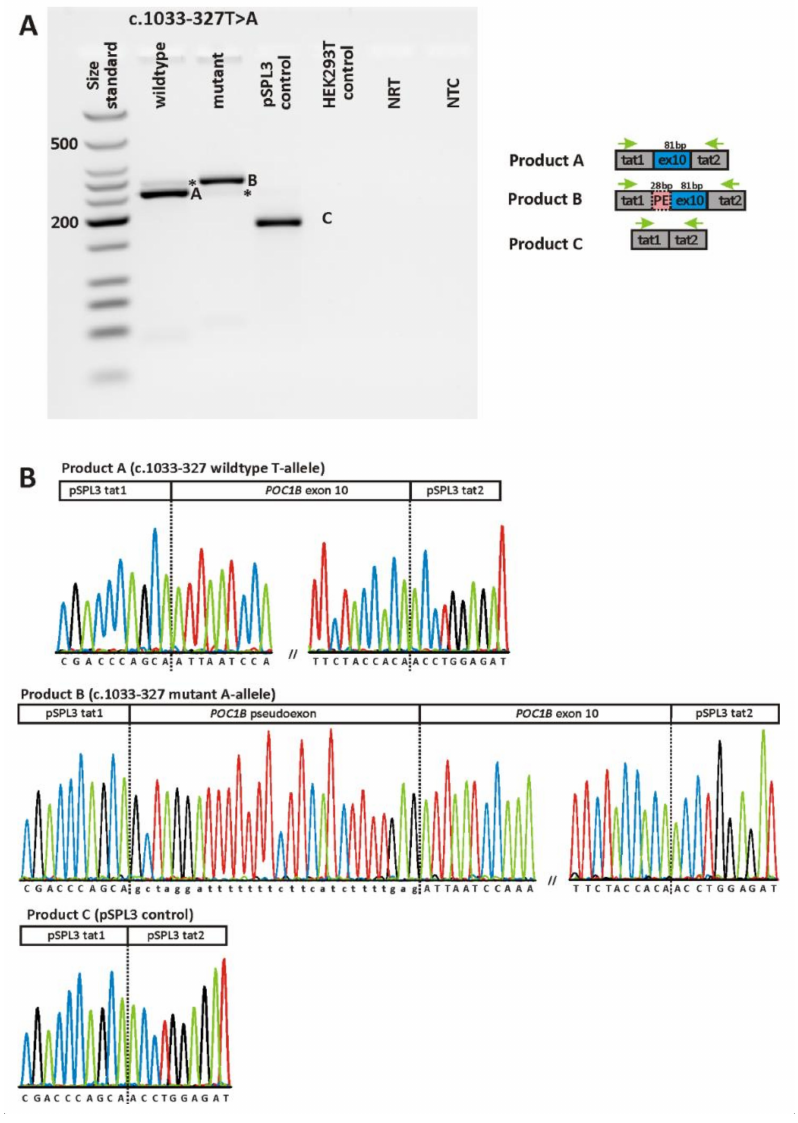
Figure 5. In vitro splicing assay for variant c.1033-327T>A. ( A ) Agarose gel electrophoresis of RT-PCR products. Gel loading is as follows: A size standard (low molecular weight DNA ladder, NEB) is loaded in the leftmost lane. RT-PCR products derived from HEK293T cells transfected with the plasmid construct harboring the wildtype allele are shown in lane 2, while those obtained upon transfection with the mutant allele are shown in lane 3. RT-PCRs from transfection with empty pSPL3 vector (lane 4) and untransfected HEK293T cells (lane 5) served as controls. NRT (lane 6), no reverse transcriptase control; NTC (lane 7), no template control. Schemes of the amplified products are presented next to the agarose gel picture. Grey boxes represent pSPL3 resident exons tat1 and tat2, and blue boxes POC1B exons, respectively. The green arrows indicate the location of the RT-PCR primers. Asterisks indicate products that could not be captured by subcloning. ( B ) Sequencing analysis of RT-PCR products. Sequencing analysis shows that the major RT-PCR product derived from transfection with the wildtype minigene construct corresponds to correct splicing (i.e., splicing of POC1B exon 10 between the pSPL3 resident exons tat1 and tat2), while the major transcript expressed by cells transfected with the mutant minigene construct shows the inclusion of a pseudoexon of 28 bp. Sequence analysis of the single RT-PCR product obtained from cells transfected with the “empty” pSPL3 plasmid shows that the two resident exons of the pSPL3 vector (i.e., tat1 and tat2) are spliced